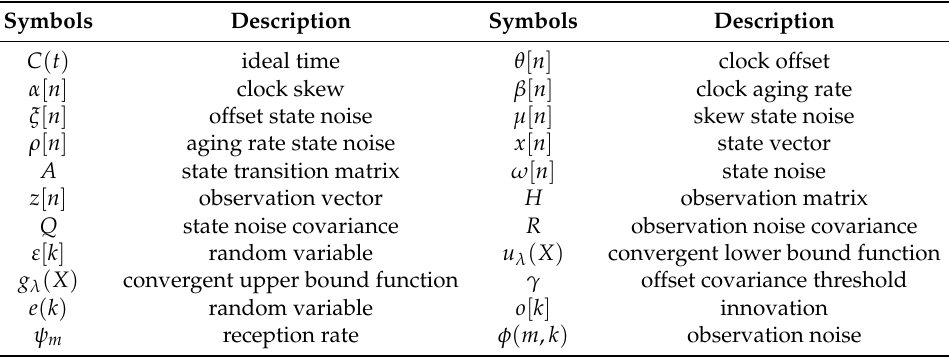
Table 1. Symbols and functions